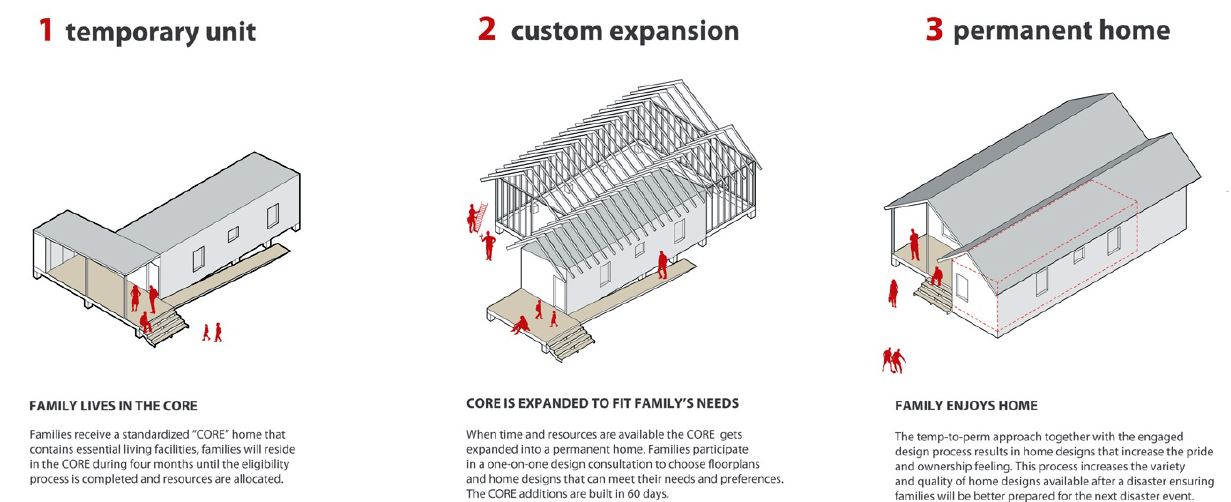
Figure 2. Rendering of the deployment phases of a RAPIDO home. Source: bcWORKSHOP (2016). Urban Planning, 2021, Volume 6, Issue 1, Pages